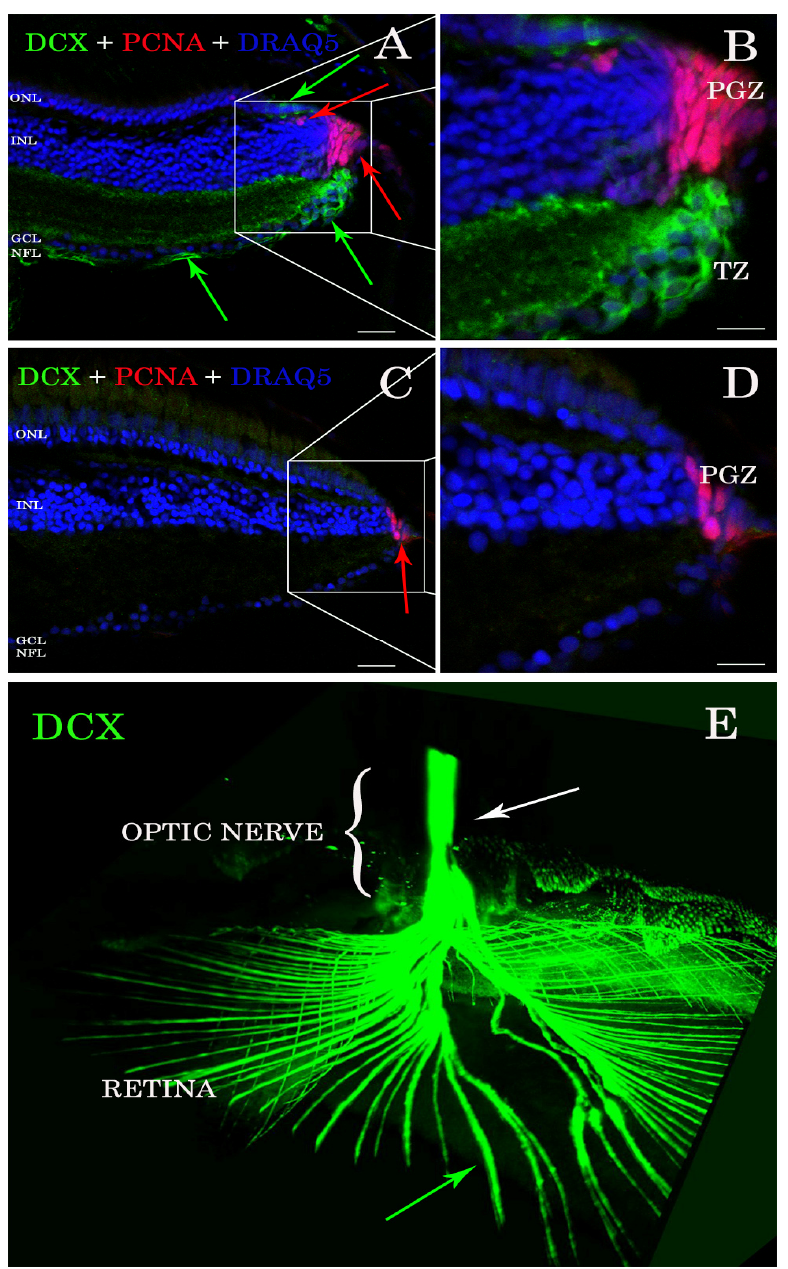
Figure 1. Sections of retina ( A – D ) and cleared tissue ( E ). DCX positive cells (green arrows) are detected in A. burtoni retina ( A ) but not in zebrafish ( C ). Magnification of ( A , C ) are presented in ( B , D ). The proliferating cell nuclear antigen (PCNA; red arrows) binding antibodies detect cells in the peripheral germinal zone (PGZ; of both species. In addition, DCX (green arrows) and PCNA (red arrows) are detected in the ONL corresponding to cones and rod precursors, respectively. Nuclei are stained with DRAQ5 (blue). No double positive cells for DCX (green arrows) and PCNA (red arrows) are found. By analyzing the whole transparent eyeball, it is possible to follow DCX positive processes in the neural fiber layer (green arrow) into the optic nerve ( E ; white arrow). Scale bar 20 μ m ( A , C ); 10 μ m ( B , D ). ONL: outer nuclear layer; INL: inner nuclear layer; GCL: ganglion cell layer; NFL: neural fiber layer.